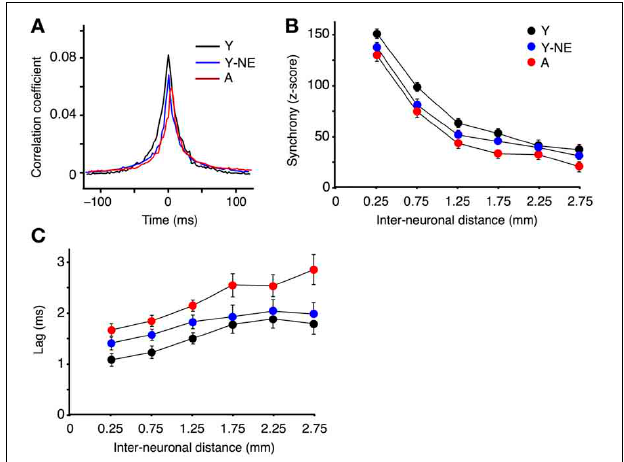
FIGURE 3 | Reduced A1 neural synchrony in noise-exposed and aged groups. (A) Mean cross-correlation functions for all A1 neuron pairs with inter-neuronal distances less than 0.5mm in Y, Y-NE, and A groups. (B) Z -score of neuronal firing synchrony (see Methods) as a function of distance for site pairs for all experimental groups. (C) Average time lag in absolute values of the peak of the cross-correlation function for all recorded pairs. (Y, number of site pairs: n = 513; Y-NE, n = 237; A, n =